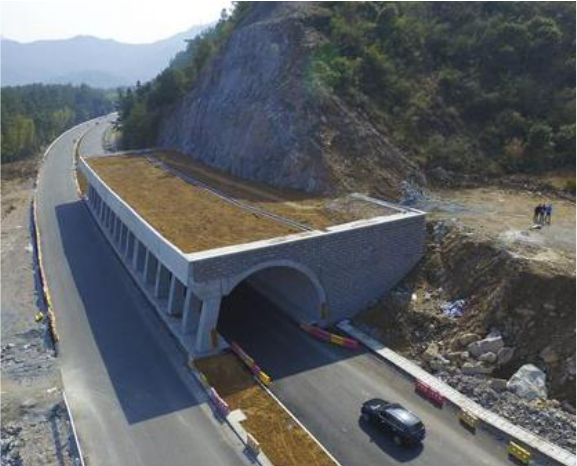
Figure 1. Rock-shed structure applied in actual engineering.